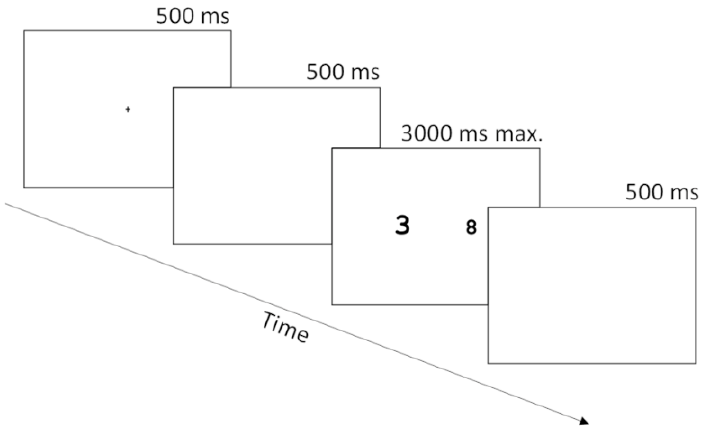
Figure 1. Schematic of a trial in the symbolic numerical Stroop task. The figure shows an example of a number/size incongruent trial with high salience of the irrelevant size dimension.